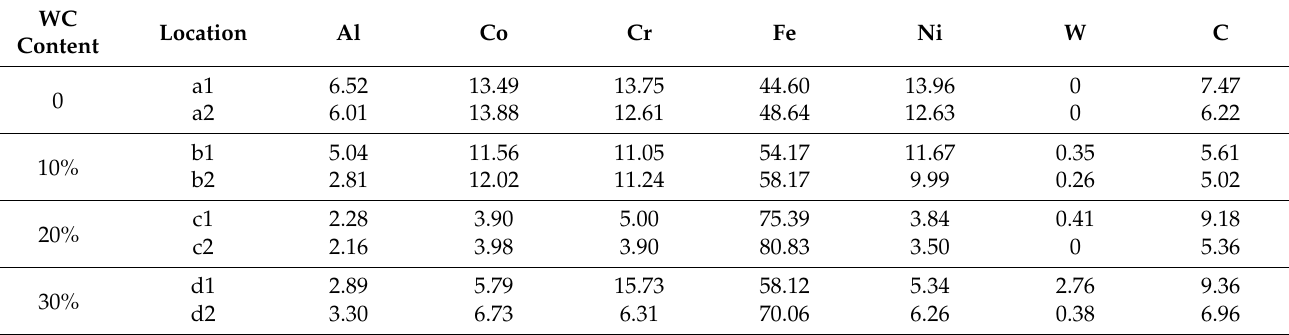
Table 3. Analysis of EDS composition in different micro areas of test alloys.